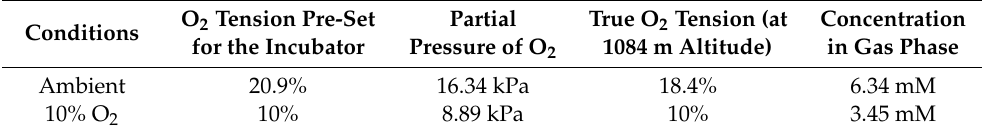
Table 1. Calculation of O 2 tension and concentration in gas phase at ~1084 m elevation (see Supple- mentary Methods).